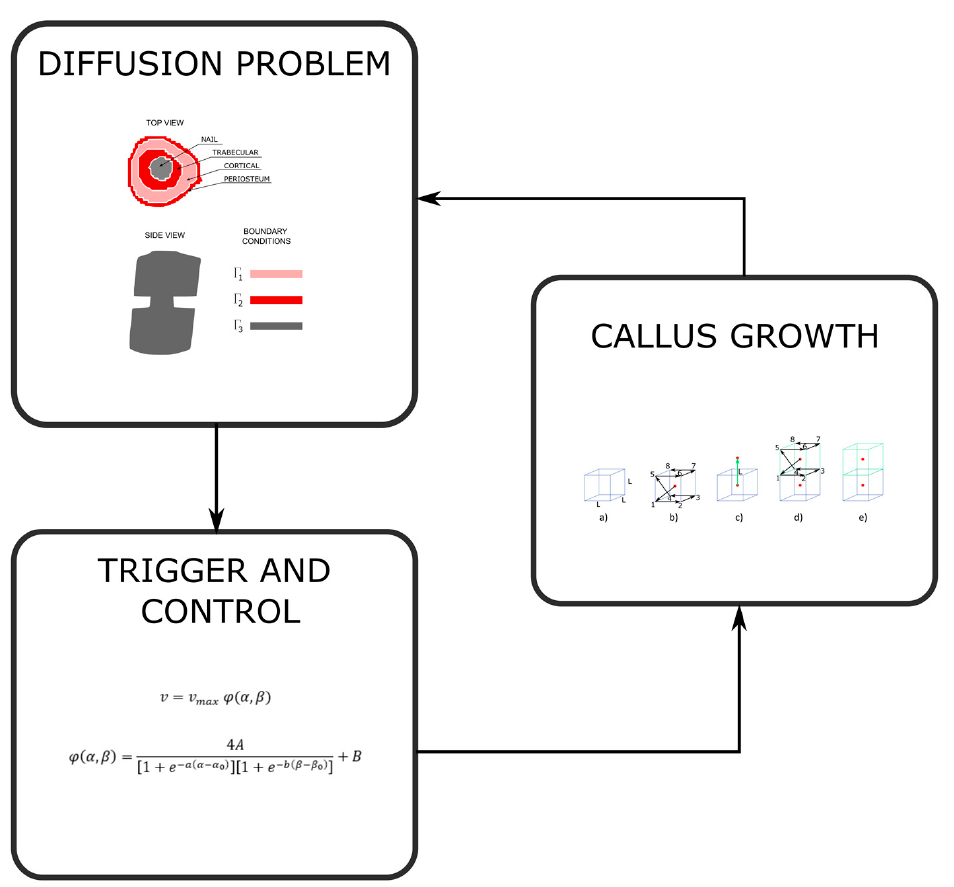
Figure 6. Explanatory diagram of the flux of the program for each time